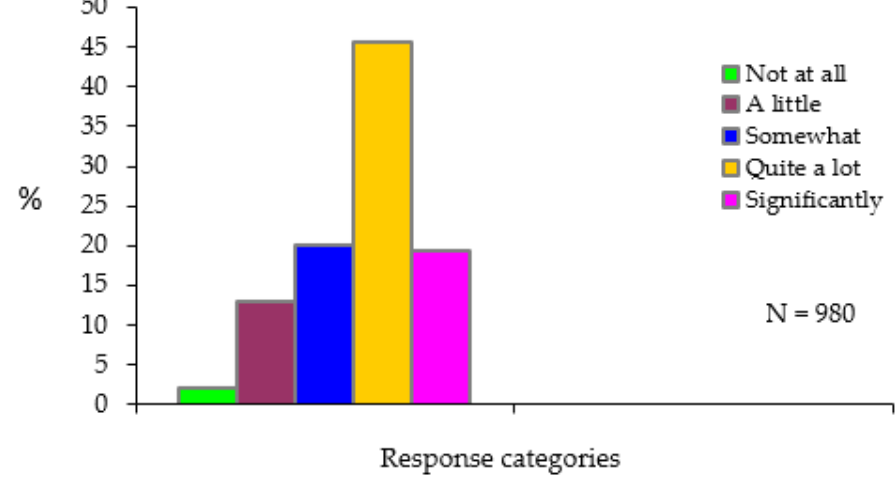
Figure 5. ‘Help settle into life at university’ frequencies.